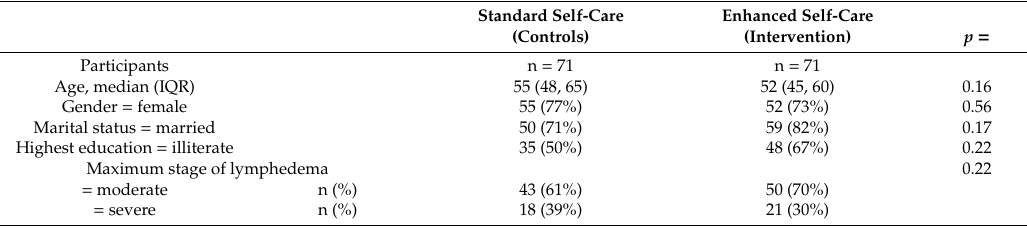
Table 1. Participant characteristics at